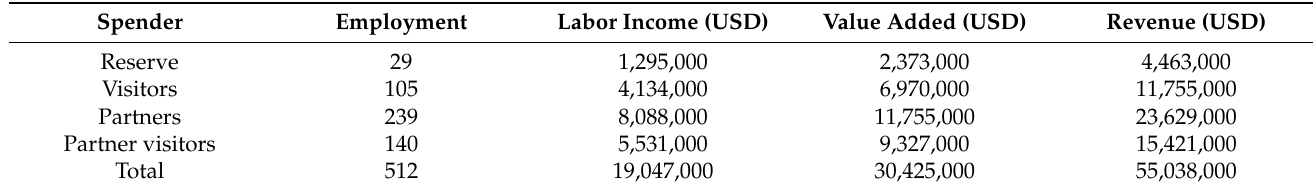
Table 5. Estimated annual contributions to employment, labor income, value added, and revenue by Rookery Bay Reserve. Spender